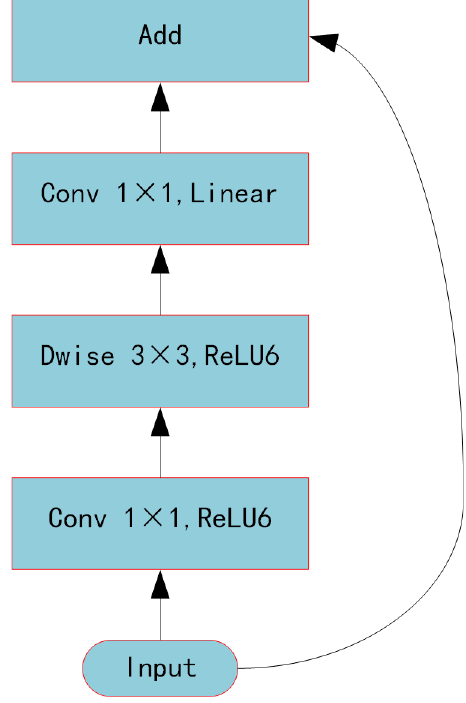
Figure 5. Inverse residual structure.